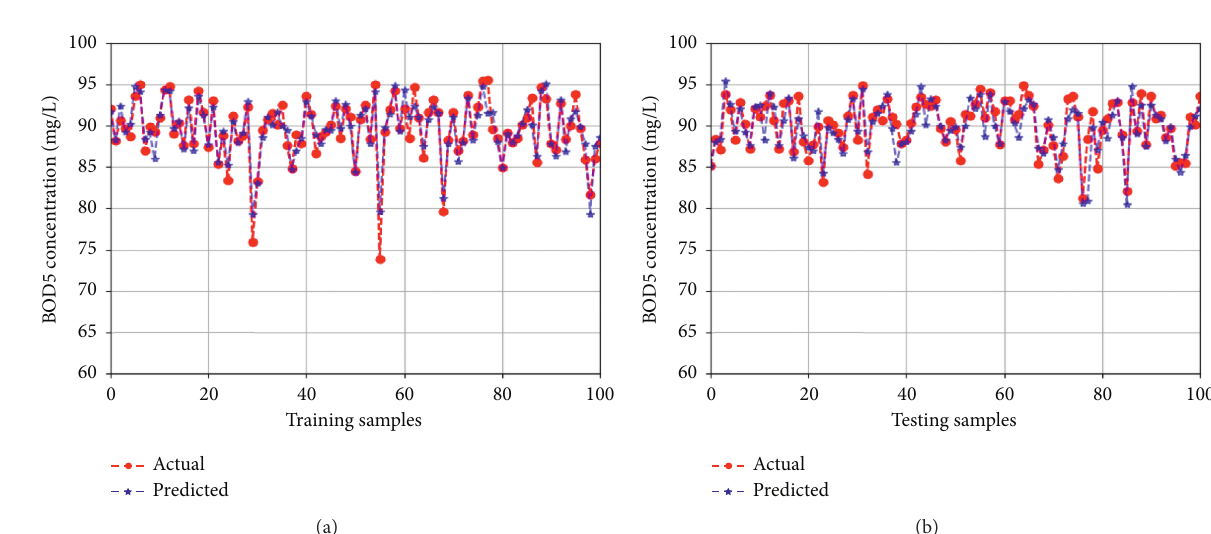
Figure 8: Soft sensor performance prediction based on